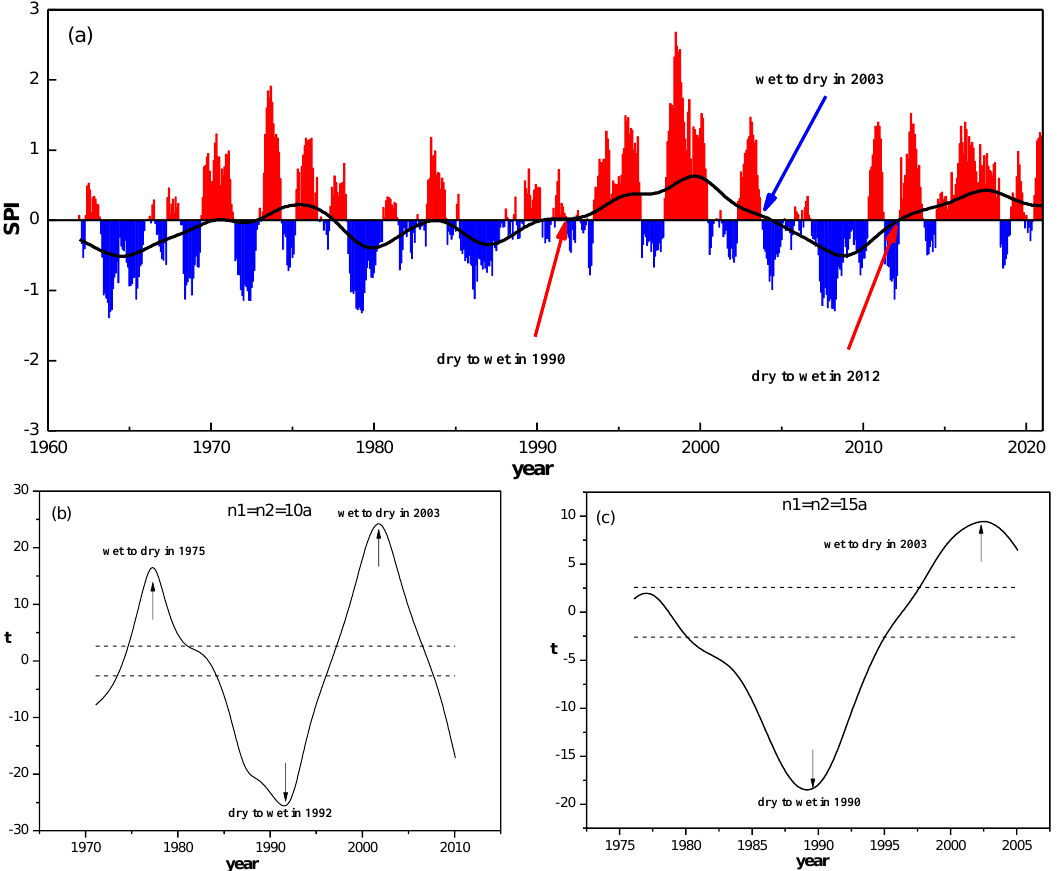
Figure 4. Temporal variation of the SPI sequence in sub–region I of the two − lake region and detection of the DWT. ( a ) Variation of SPI sequence, where red bar represents positive SPI, blue bar represents negative SPI, and the black curve indicates the decadal trend in the filtered sequence. ( b ) DWT detection of the filtered SPI sequence with the sliding window width of n being 10 years. ( c ) DWT detection of filtered SPI sequence with the sliding window width of n being 15 years. In addition, the dashed lines in Figure 4b,c indicate the critical values at significance level of 0.01.